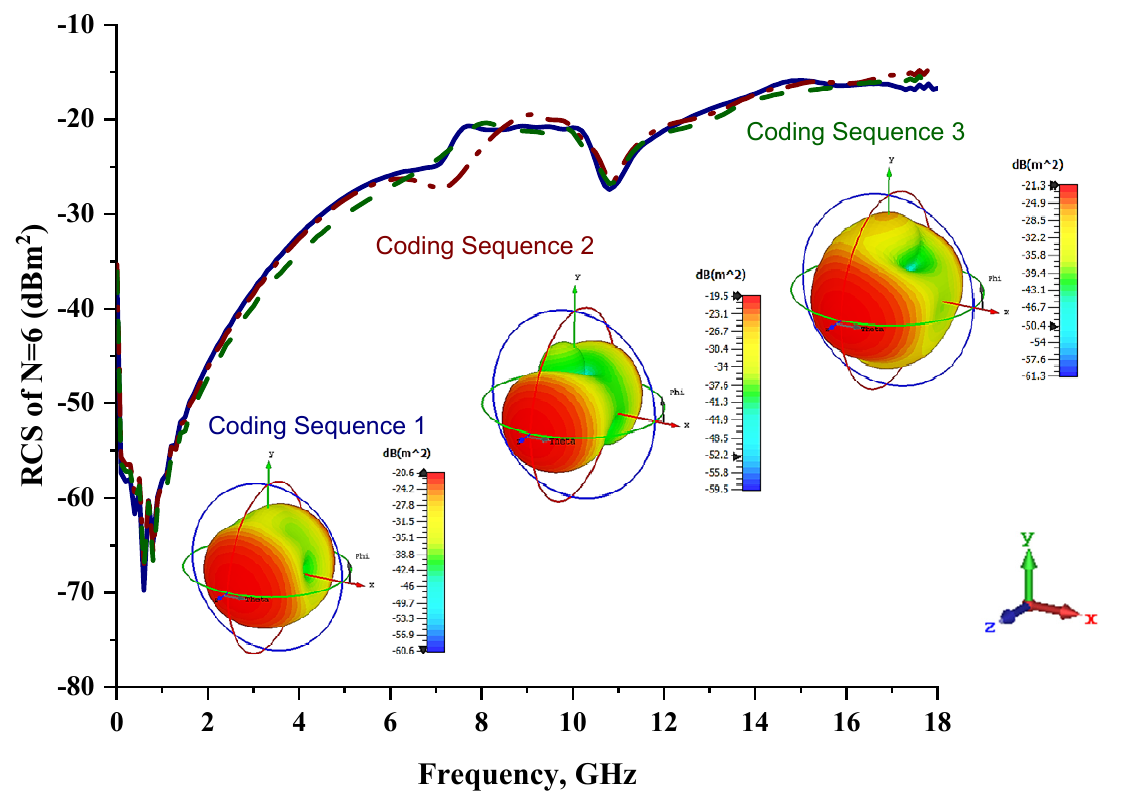
Figure 7. Monostatic RCS and bistatic scattering patterns (at 8 GHz) of three different coding metamaterials with six lattices. Table 7. Coding sequences of n = 6 for each row.